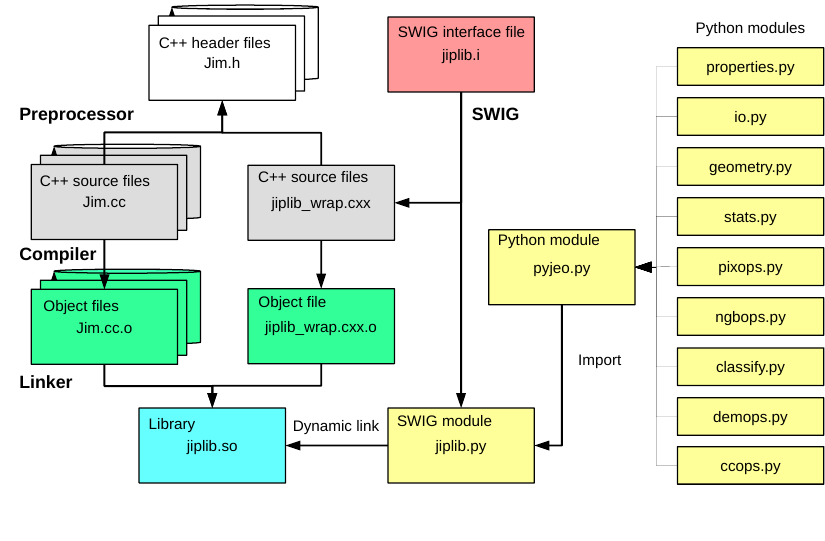
Figure 3. Using SWIG to build a Python interface from C++. Header files in white, C/C++ source files in gray, object files in green, dynamic library in cyan, Python modules in